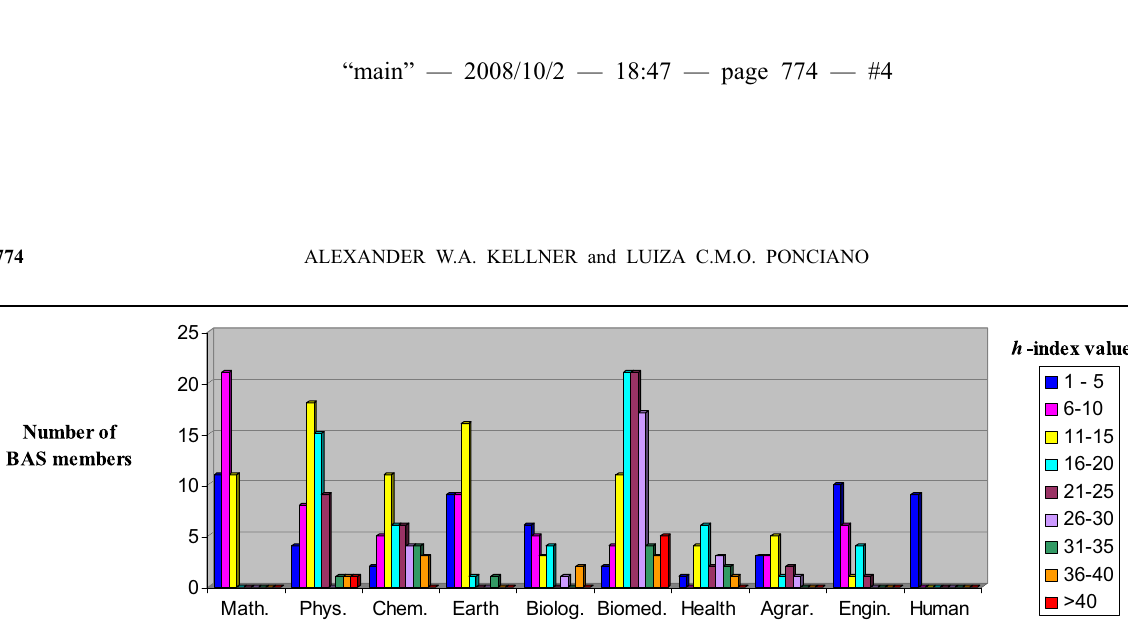
Fig. 1 – The h -index distribution in Brazilian Academy of Sciences